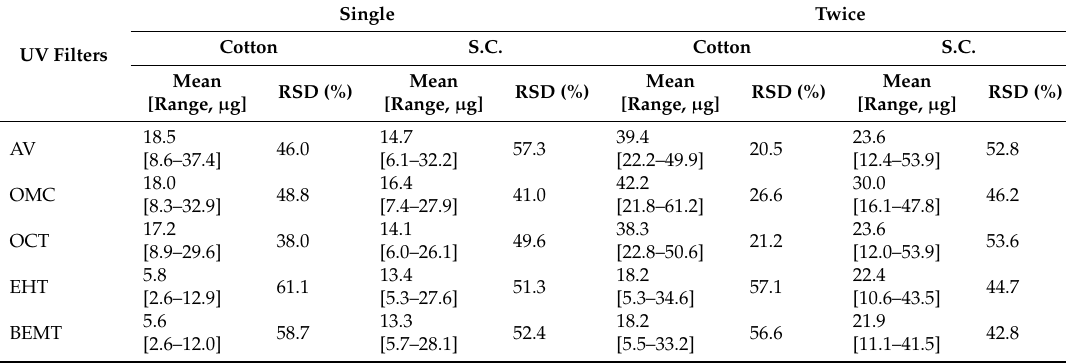
Table 5. UV filter contents of cup-method samples after single or double applications of the home-made sunscreen (w / o) for 8 h (subjects = 10).